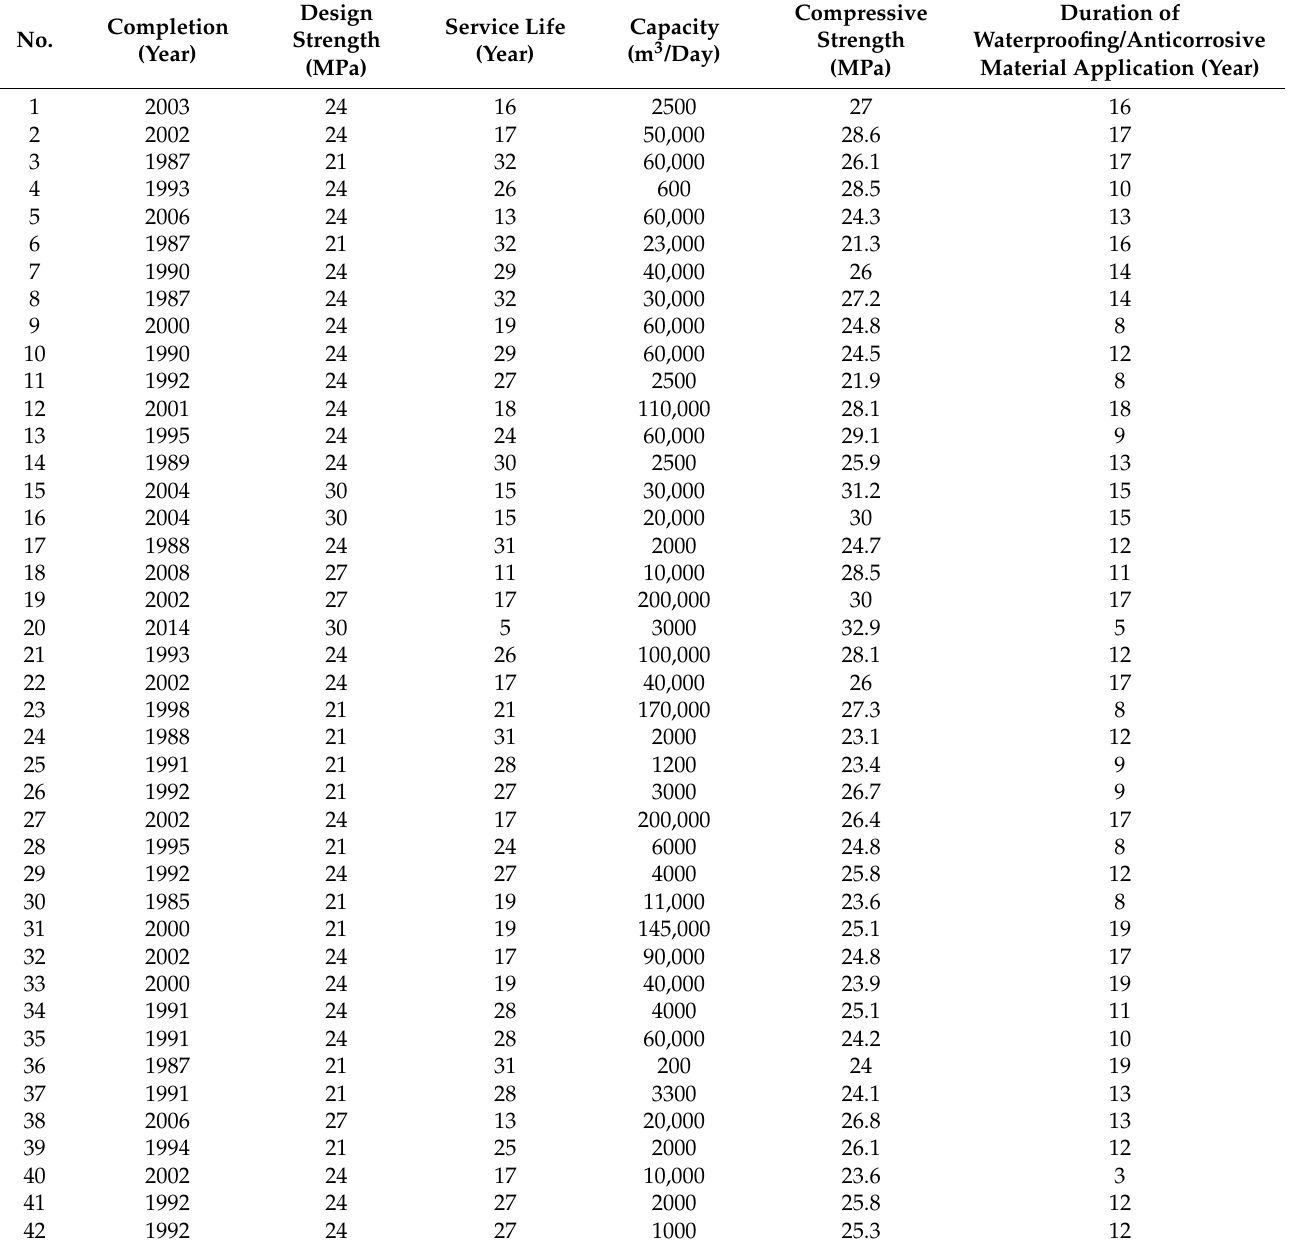
Table 2. Specifications for each water supply